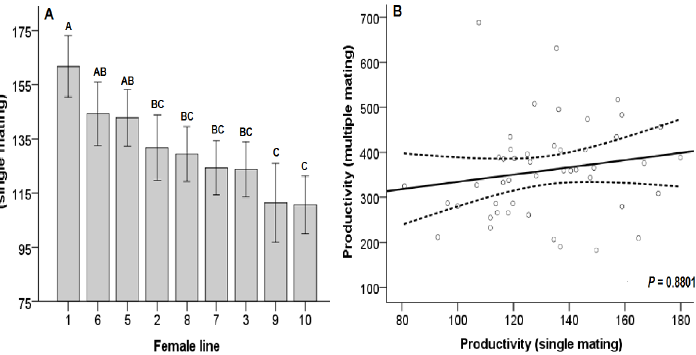
Fig 5. Reproductive success by line and by mating level. (A) Variation of lifetime reproductive success of singly mated females separated by female line. Columns with the same letters are not significantly different. Error bars represent the 95% CI. (B) Regression of mean productivity of females with multiple matings on productivity of singly mated females. Dashed lines represent the 95% CI.